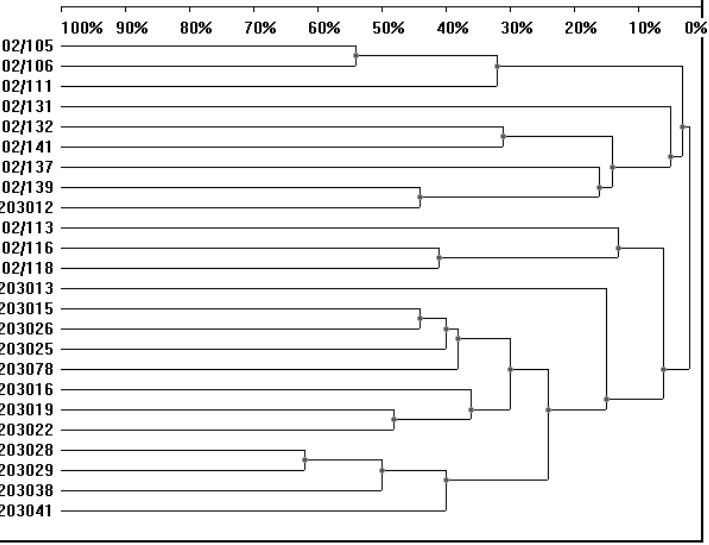
Fig.1. dendrogram of similarity among genotypes of H. annosum sensu